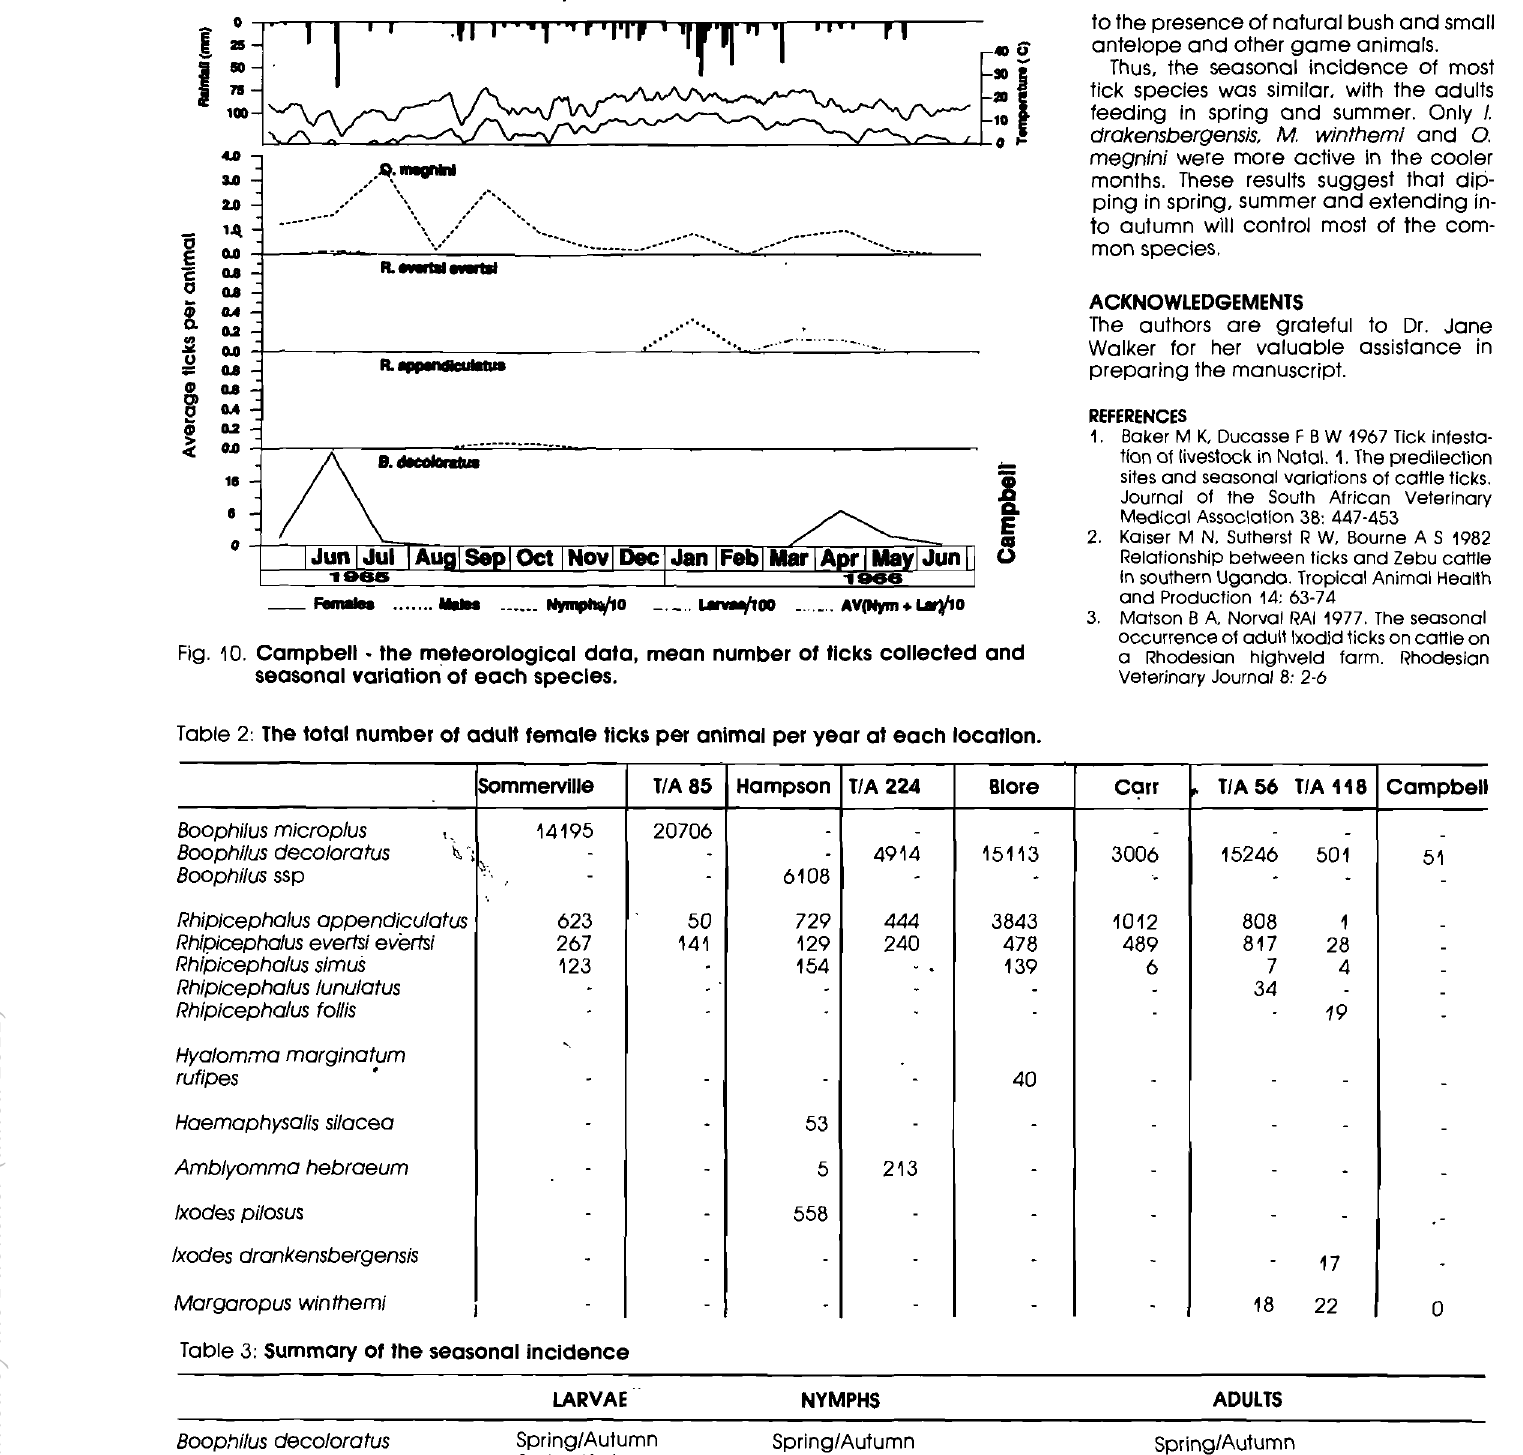
Table 3: Summary of the seasonal